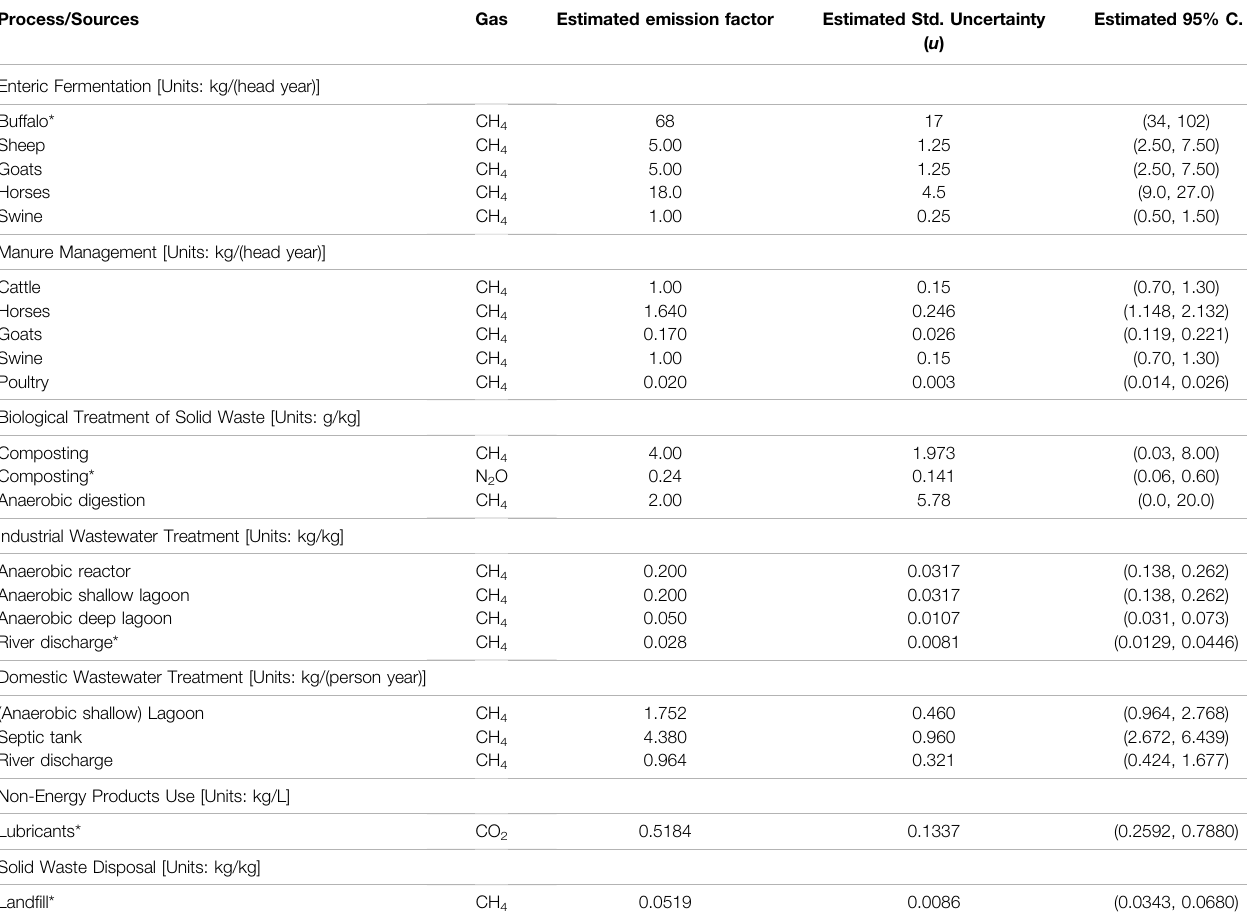
TABLE 2 | Estimated values, absolute standard uncertainties, and 95% absolute con fi dence intervals for the emission factors using the Monte Carlo simulation method. Updated values are suggested for emission factors marked with an asterisk (*). Process/Sources Gas Estimated emission